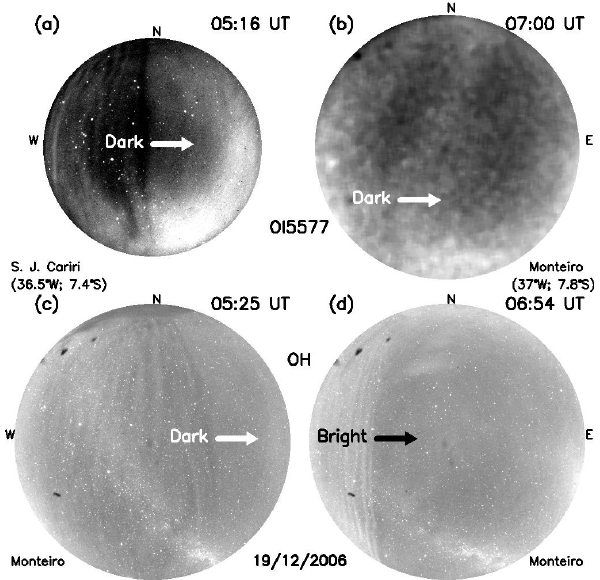
Figure 1. All-sky images of the twin mesospheric bores: (a) the first bore (front dark) observed at 05:25UT in the OH image at Monteiro; (b) the second bore (front bright) observed at 06:54UT in the OH image at Monteiro; (c) the first bore (front dark) ob- served at 05:16UT in the OI5577 image at São João do Cariri; (d) the second bore (front dark) observed at 07:00UT in the OI5577 image at Monteiro. Horizontal arrows indicate approximately the propagation direction of the bores. (See the movie in the Sup- plement for further details about the propagation of these bore,